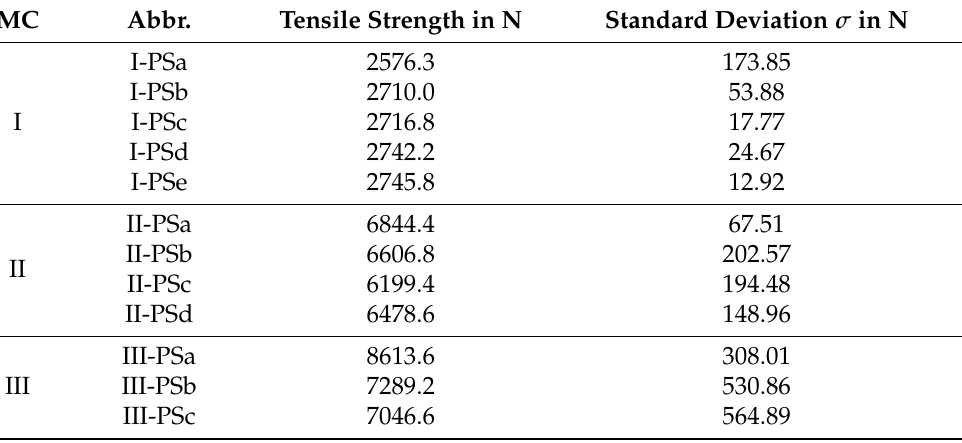
Table A3. Lap shear test results for all FPJ joined